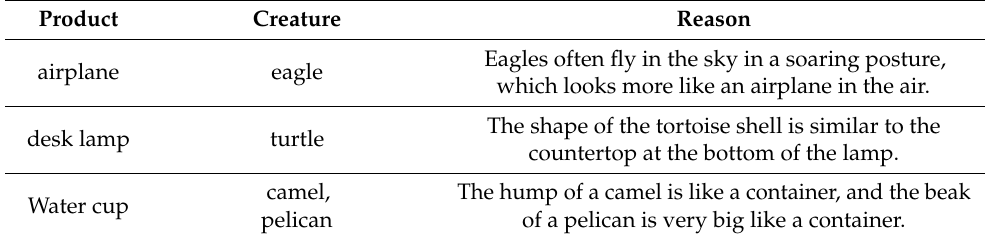
Table 2. Product form- creature form reasoning (49 times).